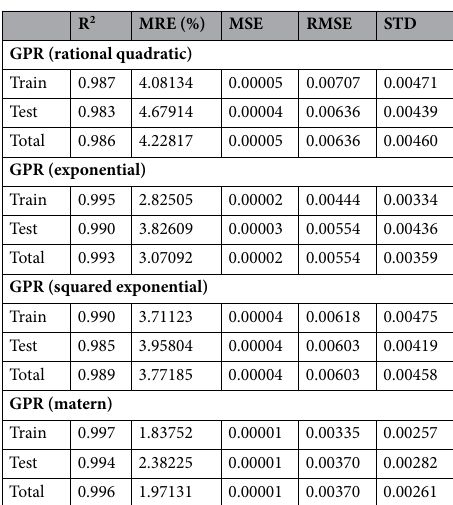
Table 2. The statistical parameters of developed